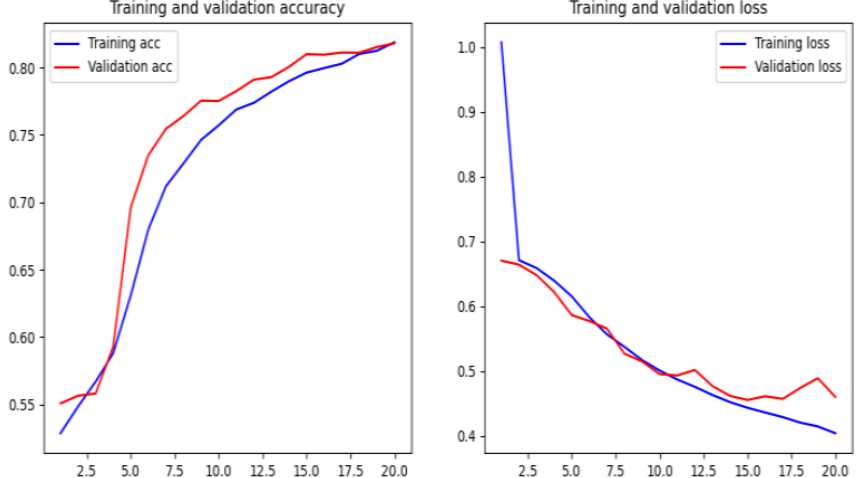
Figure 16. Evaluation of deep neural network (DNN) model on D2 using FG2.